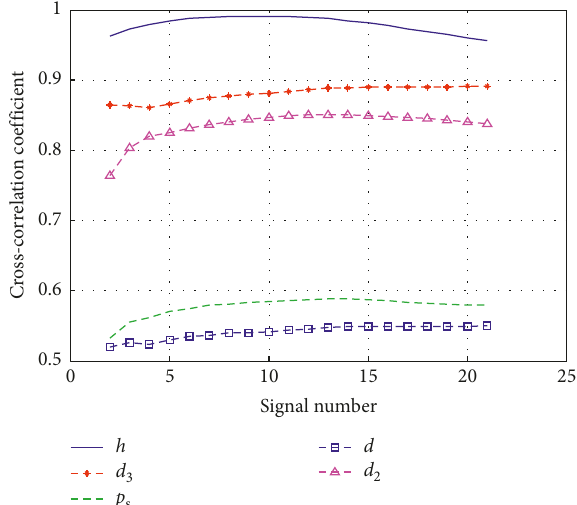
Figure 3: Correlation coefficient of the stiffness and influence